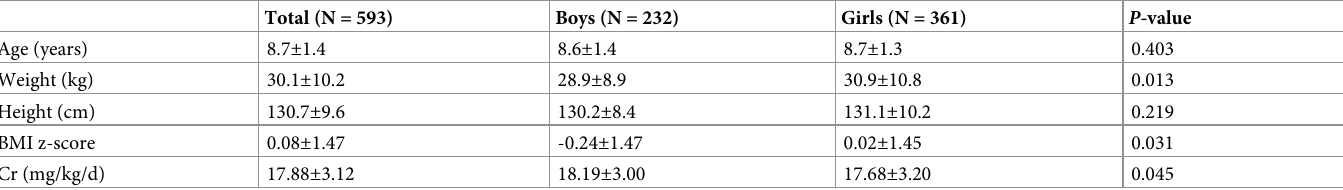
Table 1. Anthropometric characteristics of the sample population.